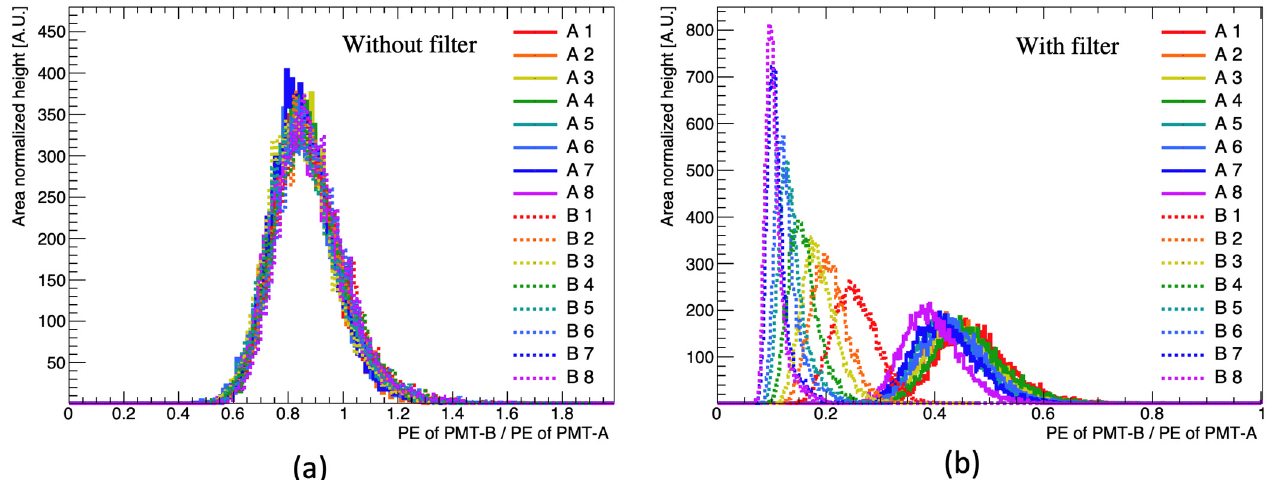
Figure 7. Observed PE ratio between PMT-A and PMT-B at different fluor concentrations: ( a ) Mea- surement without using the filter. The difference in the photon detection efficiency is estimated by comparing the Compton edges observed by PMT-A and PMT-B in Figure 4; the difference is approximately 15%. The observed PE ratio distribution between PMT-A and PMT-B is shifted to the left; ( b ) Measurement with the filter. The PE ratio distribution varies with the fluor concentration when the filter is